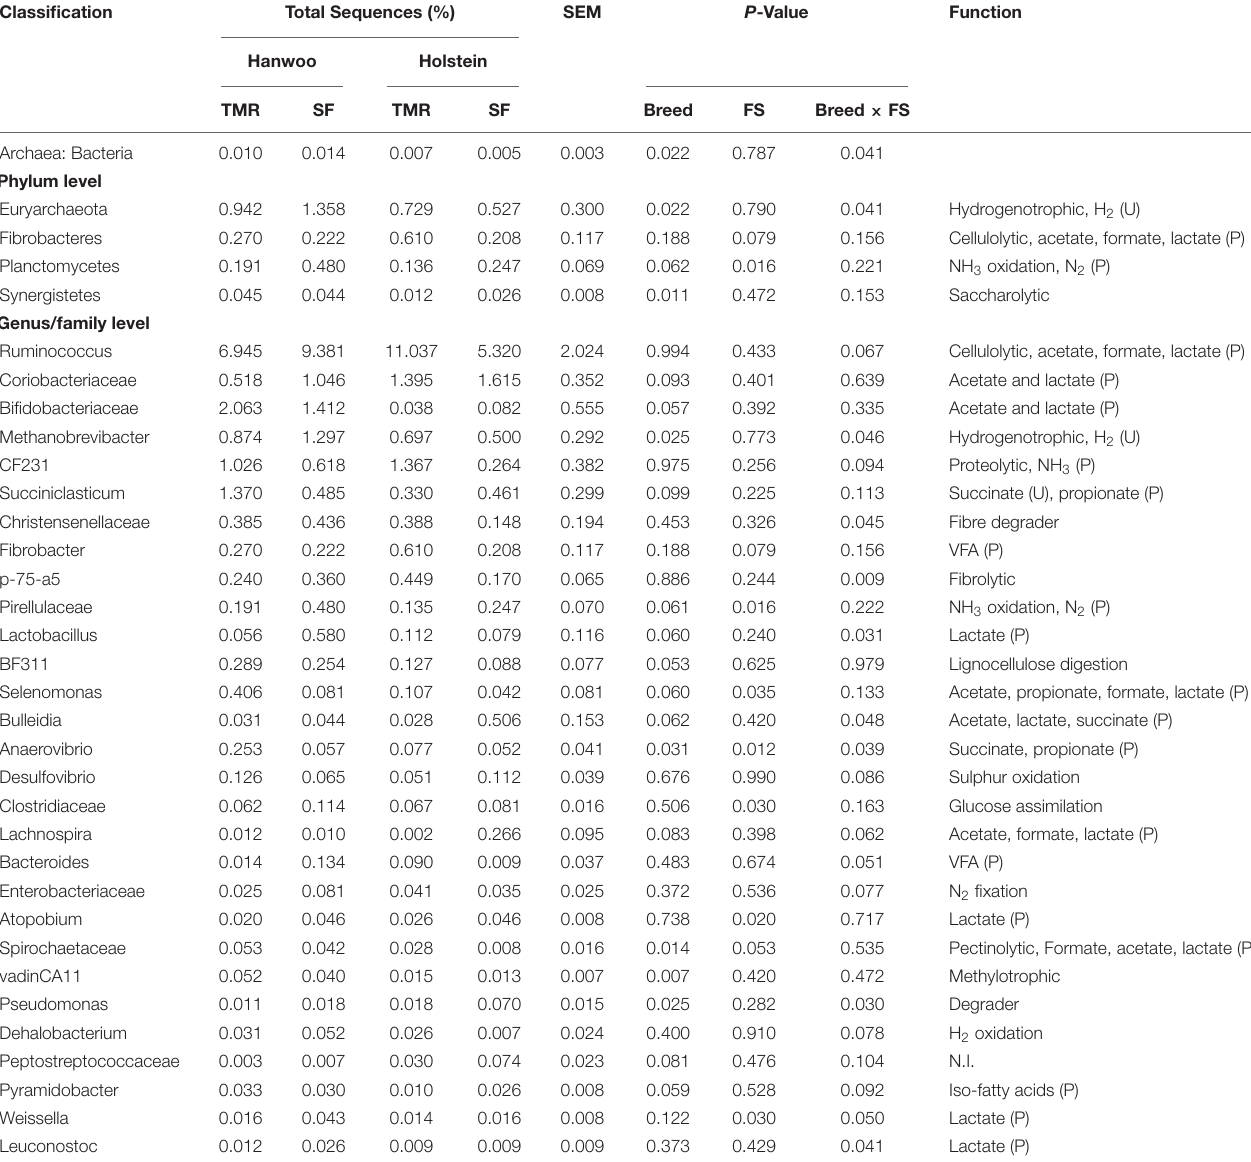
TABLE 6 | Relative abundance of taxa in the Hanwoo and Holstein steers fed by different feeding systems.